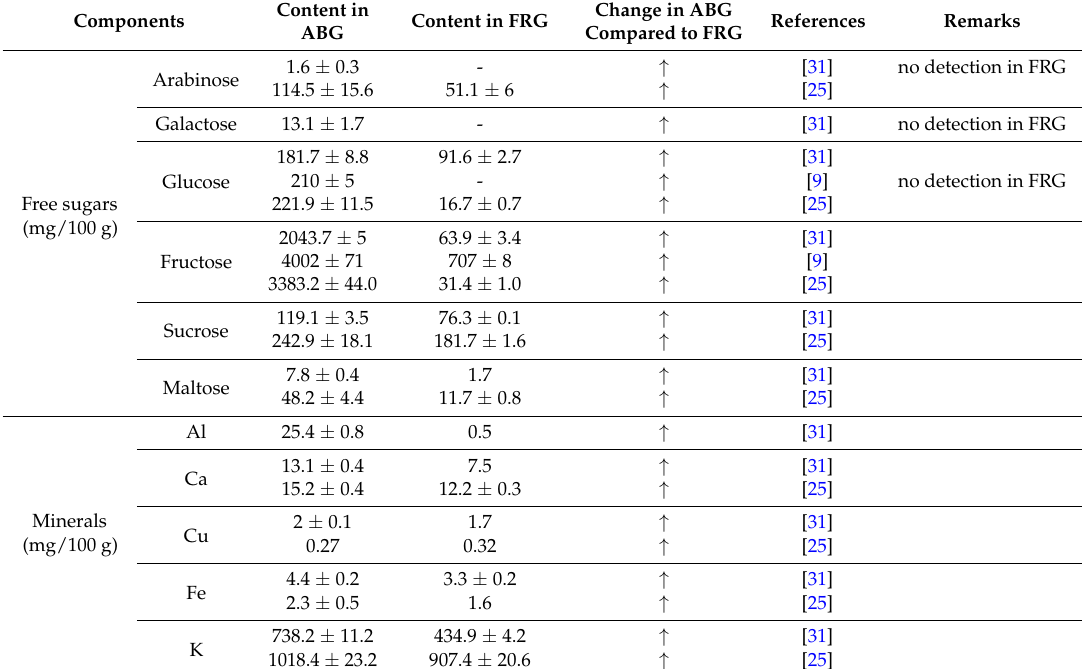
Table 3. Comparison of contents of free sugars and minerals between ABG and